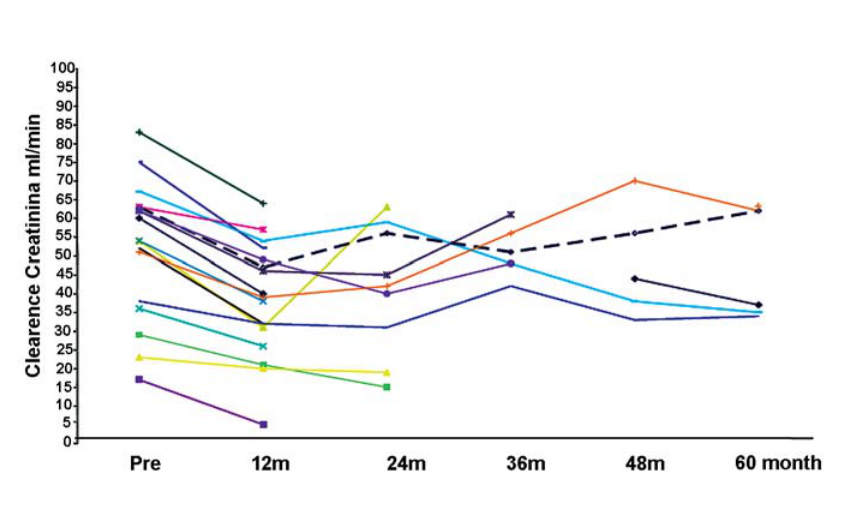
Figure 5 – Patients with a worsening of creatinine clearance (n =